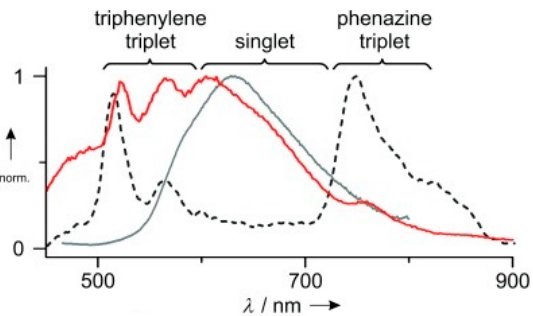
Figure 13. OLED EL spectra of 58 compared to solution PL (gray line) and delayed PL from dilute dispersions in polystyrene films (dashed line). The delayed PL is measured in vacuo to prevent triplet quenching. Adapted with permission from [61].